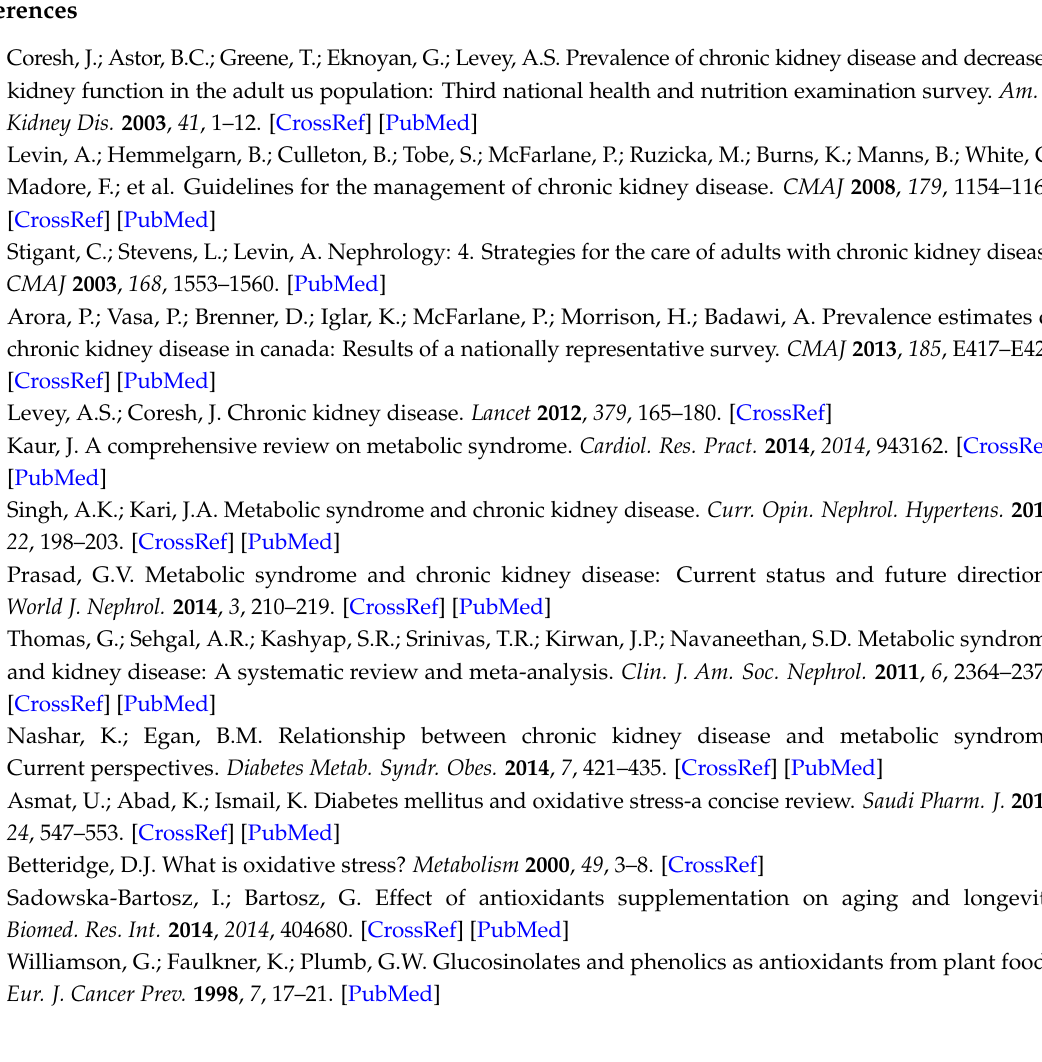
Figure S1: Antioxidant activity of WGP extract, Table S1: The blood chemistry of obese male ZSF1 rats over six months of daily intake of whole grape powder (WGP) compared to sugar (Vehicle) group, Table S2: Oxidative stress-related gene expression in kidney cortex of WGP-fed rats compared to Vehicle controls at the end of six months of feeding experiment, Table S3: Blood chemistry of metabolism of obese male ZSF1 rats (approximately eight weeks old) compared with a reference in the literature